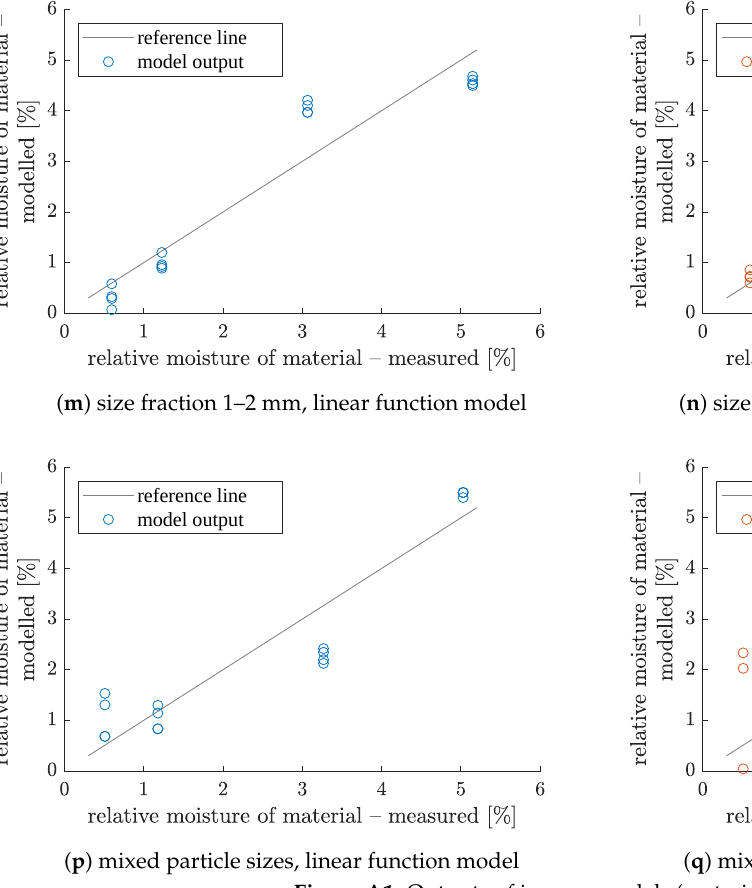
Figure A1. Outputs of inverse models (material moisture vs. image median intensity) as obtained in leave-one-out